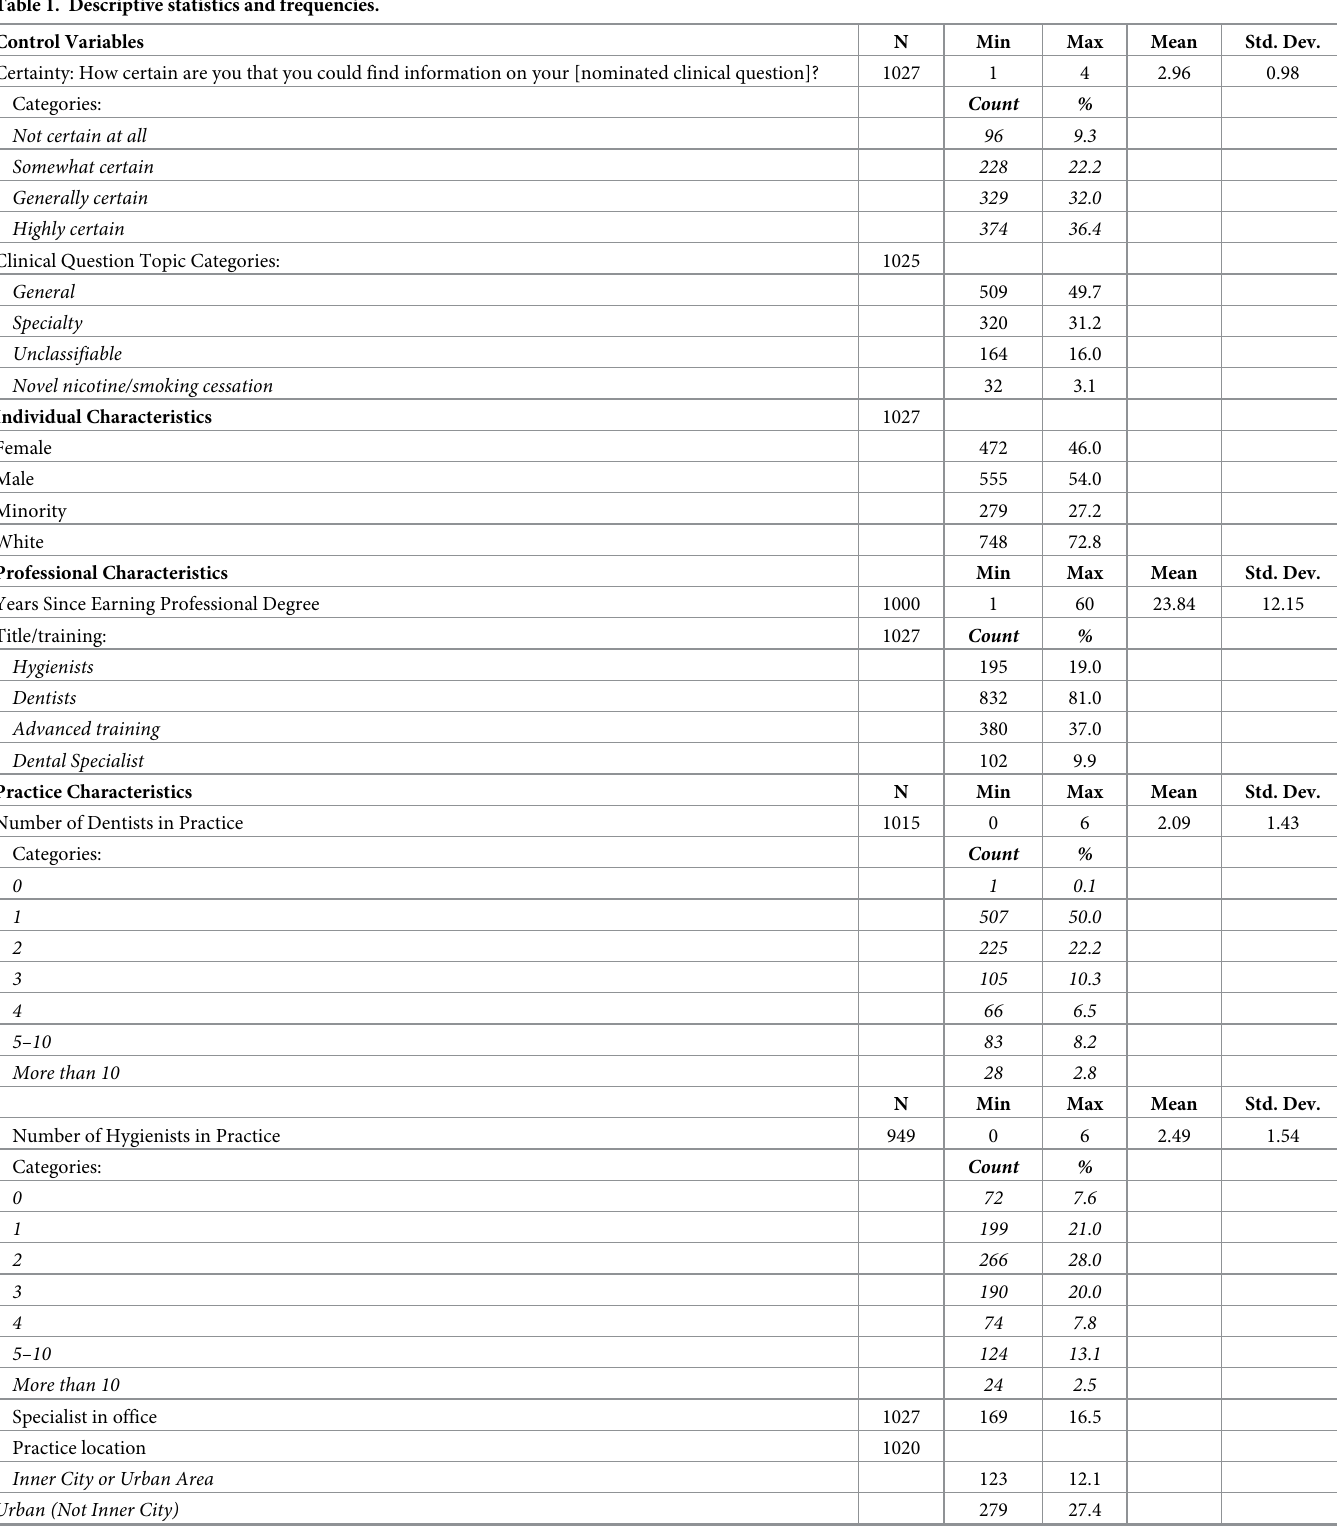
Table 1. Descriptive statistics and